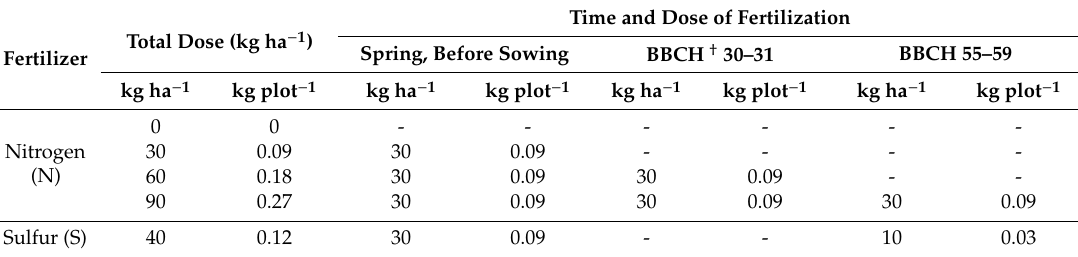
Table 2. The doses of nitrogen (N) and sulfur (S)